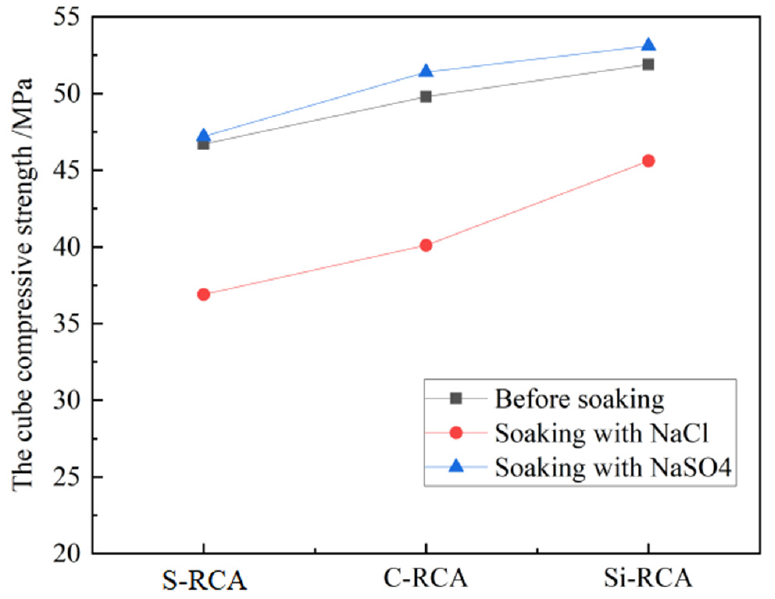
Figure 8. Compressive strength of RC.